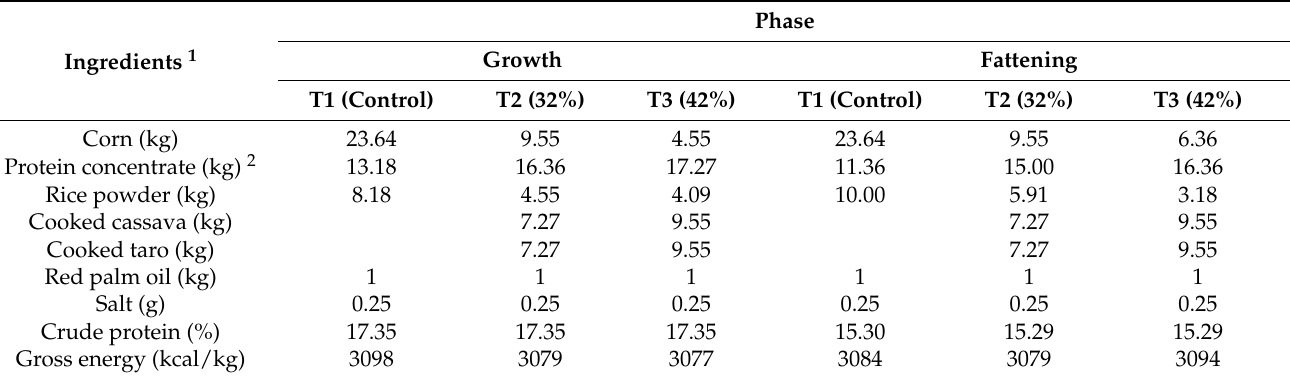
Table 2. Nutritional value and composition of the used diets.